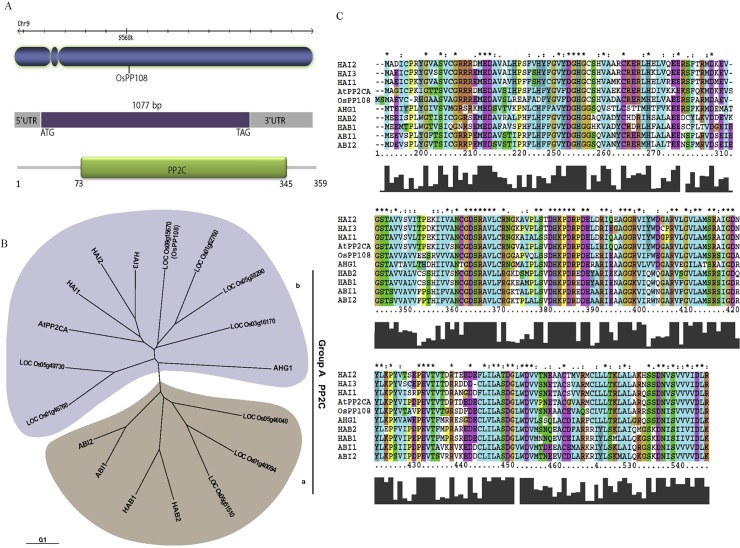
Gene, protein structure and sequence analysis of OsPP108.(A) Localization of OsPP108 gene on chromosome 9 of rice, gene structure showing that OsPP108 is intronless and has 1077 bp open reading frame. Protein structure showing that OsPP108 protein is comprised of 359 amino acid residues and PP2C catalytic domain starts at amino acid 73 and ends at 345. (B) Phylogenetic analysis of group A PP2Cs from rice and Arabidopsis. Group A PP2Cs are further divided into two sub-clades a and b and OsPP108 belongs to sub-clade b. Tree was constructed with MEGA5, scale bar represents amino acid substitution per site. (C) Multiple sequence alignment of OsPP108 with the entire group A PP2Cs from Arabidopsis. Amino acid position is indicated at the bottom of the alignment. Multiple alignments were done in clustalX2.0.8 and manually edited to show the conservation clearly.